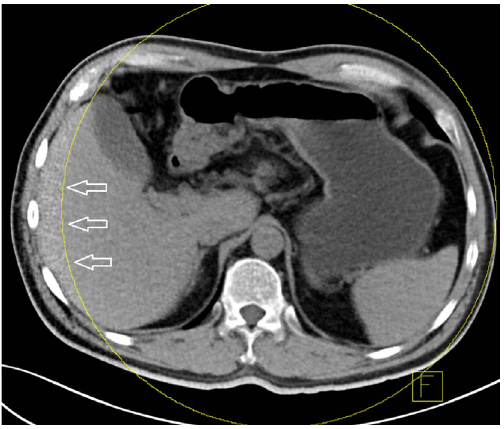
Figure 6. Excluded relevant anatomy. The yellow circle relates to the smaller (33 cm) field of view of the smaller detector. Iodine maps and subsequent iodine subtraction to create the virtual non-enhanced images can only be performed within the circle. In larger patients ( . 40 cm actual body diameter) or patients with improper position important anatomy may be excluded from the subtraction. In this example the lateral aspect of the right lobe of the liver fails to ‘become unenhanced’